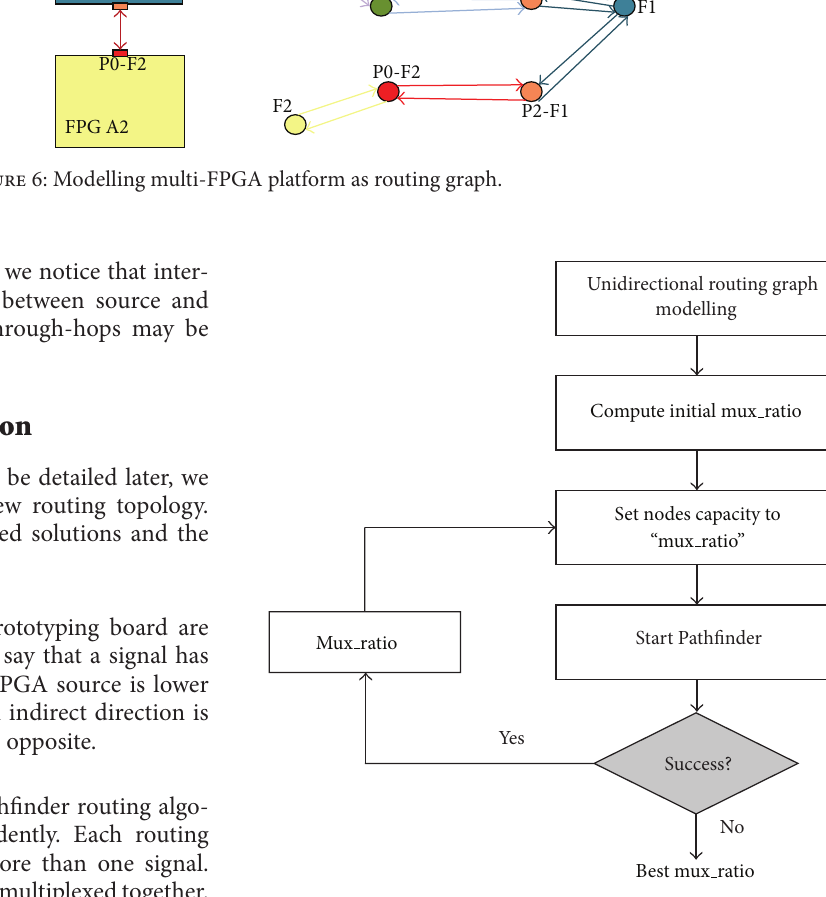
Figure 7: Routing flow on unidirectional